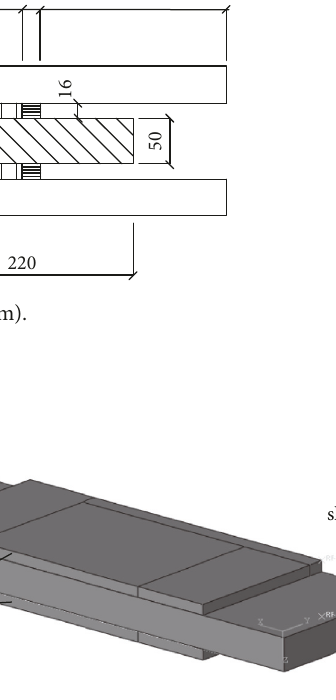
Figure 10: Finite element model of ILSD-LS.